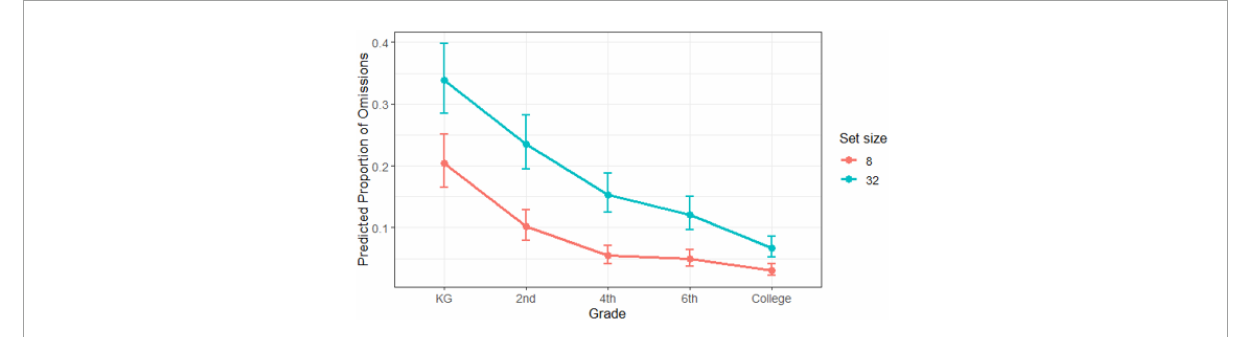
FIGURE6 Proportion of omissions estimated with the General Linear Mixed Model in the visual search task as a function of grade. Bars represent confidence intervals for each estimation